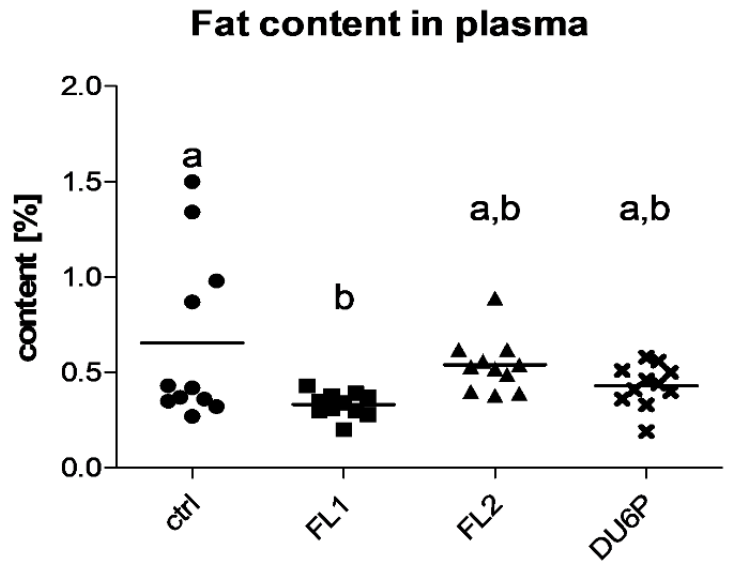
Figure 4. Fat content in plasma samples in control (circles), FL1 (squares), FL2 (triangles) and DU6P (crosses). Data are illustrated as the mean ± SEM (standard error of the mean) and designated significant if p < 0.05 (Tukey posttest: different letters correspond to different levels of significance).